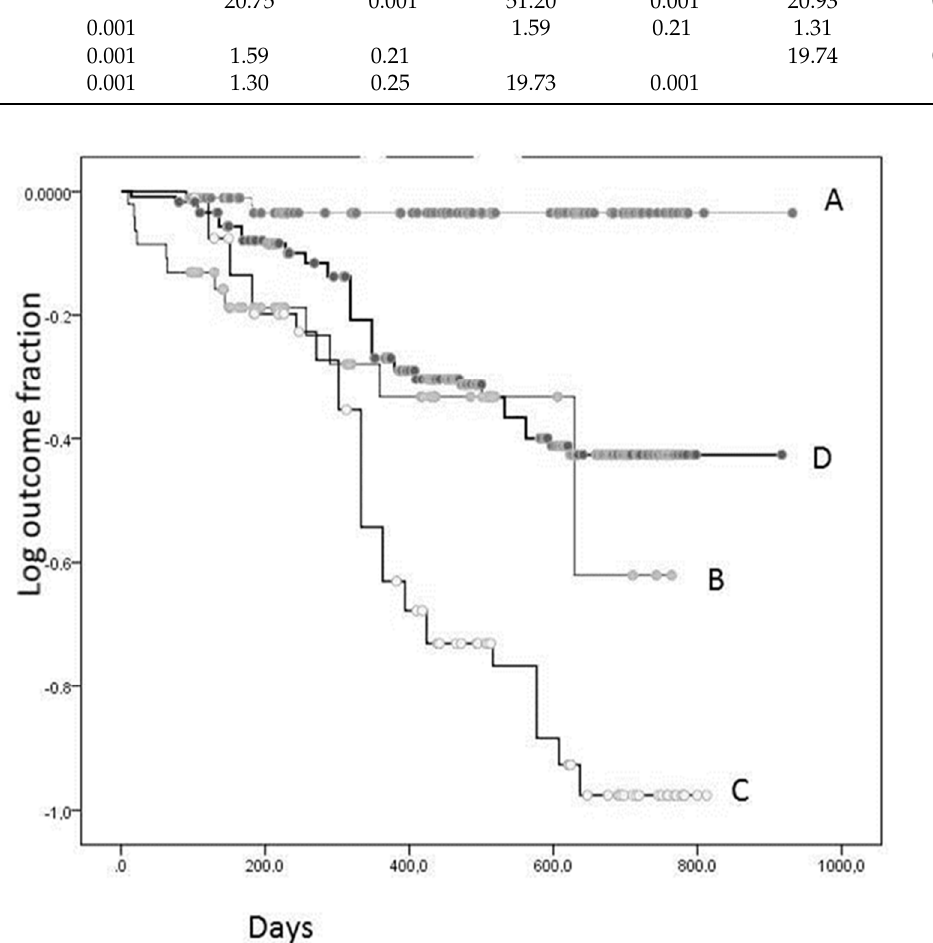
Figure 4. Kaplan-Meier analysis for COVID-19 relapse outcome in various groups of respondents: A, vaccinated; B, IgG-positive; C, not vaccinated; and D, IgG-negative.